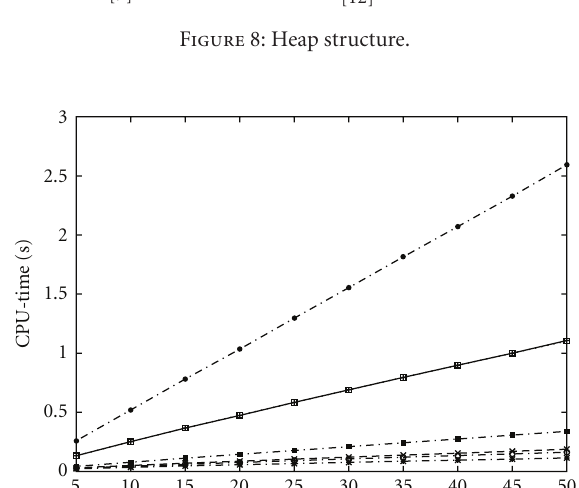
Figure 8: Heap structure.